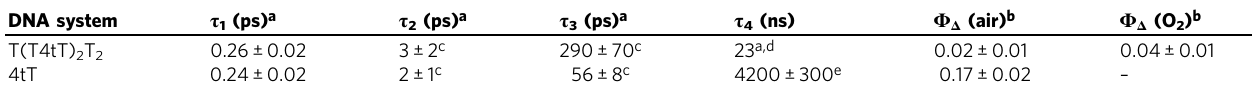
Table 1 Transient-absorption lifetimes and quantum yields of singlet-oxygen generation. DNA system